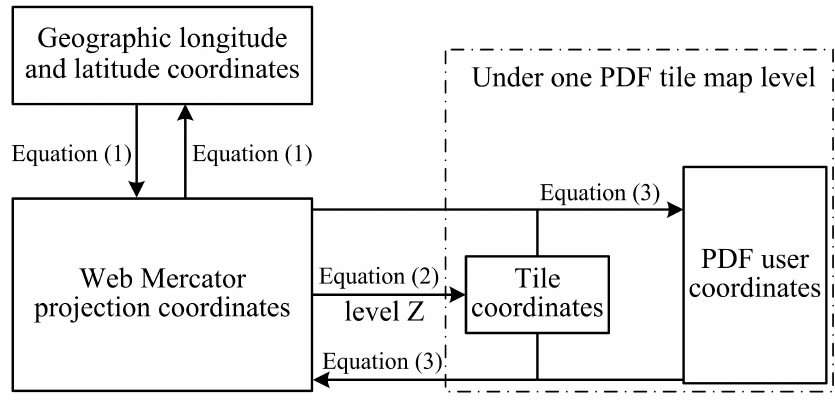
Figure 3. Coordinate transformations in the PDF tile map.